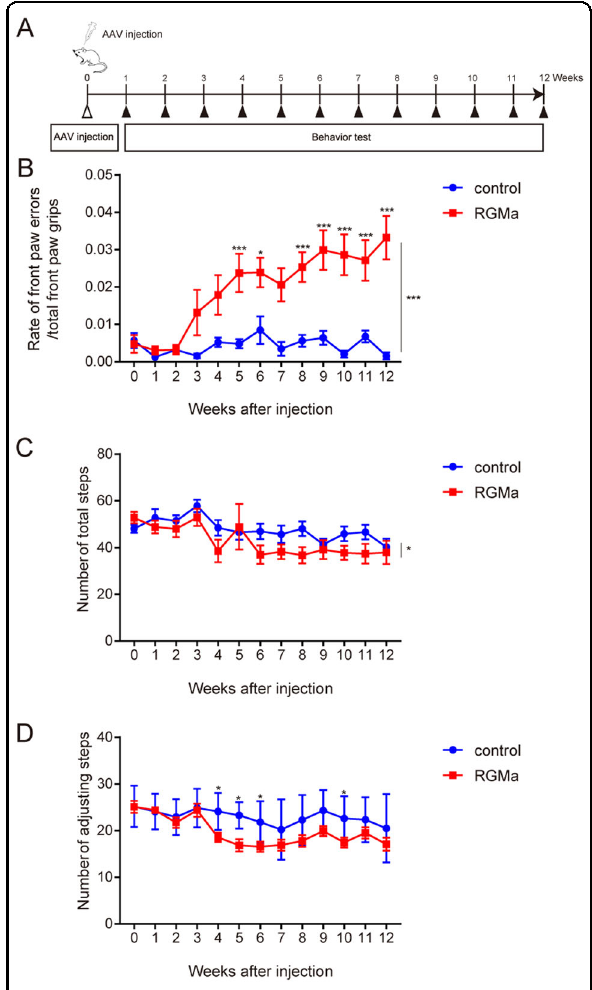
Fig. 5 Increased RGMa in the SN induces motor impairments. A Schematic representation of the timeline of AAV injection in the SN and the behavioral tests. B , C Time-dependent changes in forepaw faults ( B ) and the number of total steps ( C ) in the grid test were measured in mice injected with AAV. n = 17 – 18. * P < 0.05, ** P < 0.01, *** P < 0.005, two-way repeated-measures ANOVA with Bonferroni multiple comparison test. D Increased expression of RGMa causes a decrease in adjusting steps as measured by the stepping test. n = 17 – 18. * P < 0.05, two-way repeated-measures ANOVA with Bonferroni multiple comparison